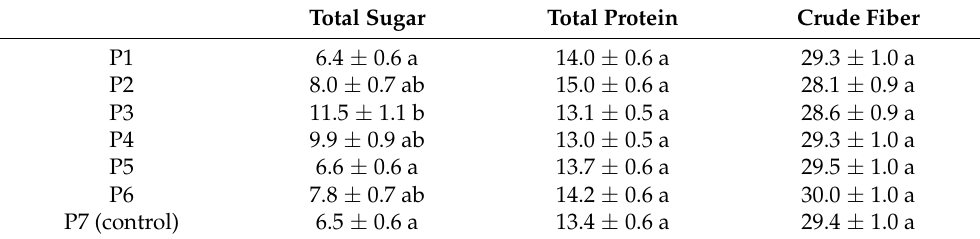
Figure 7. Microbial population changes during the second stage of the experiment. Storage time: 4 and 10 months. Bars marked with the same letters indicate no statistical difference ( p < 0.05); results were analyzed separately for each group of microorganisms.